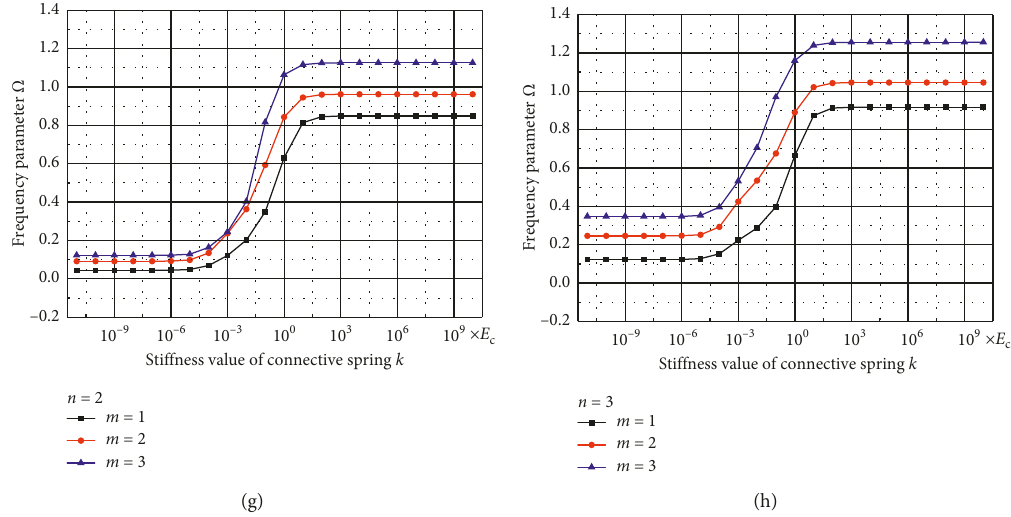
Figure 4: Frequency parameters